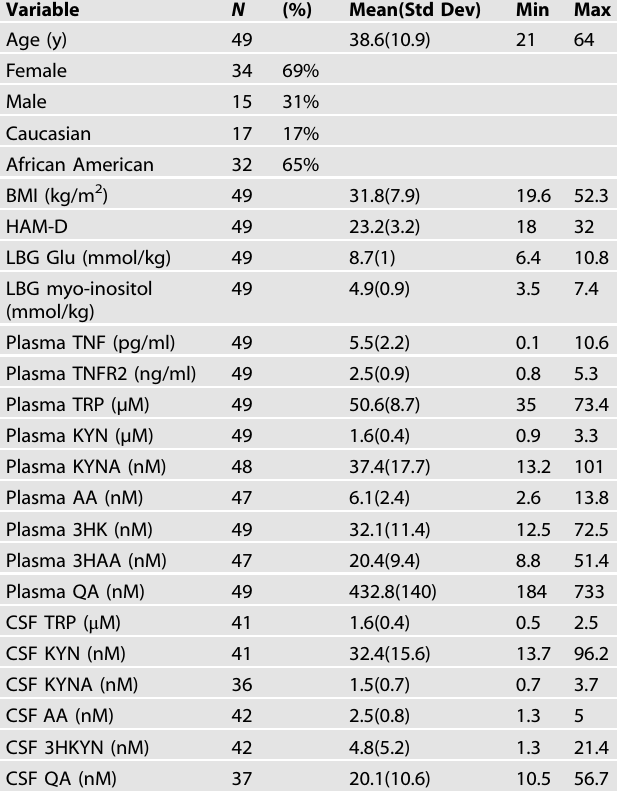
The table presents the background data of the sample. BMI body mass index, HAM-D 17-item Hamilton depression rating scale, LBG left basal ganglia, Glu glutamate, TNF tumor necrosis factor, TNFR2 tumor necrosis factor receptor type 2, TRP tryptophan, KYN kynurenine,